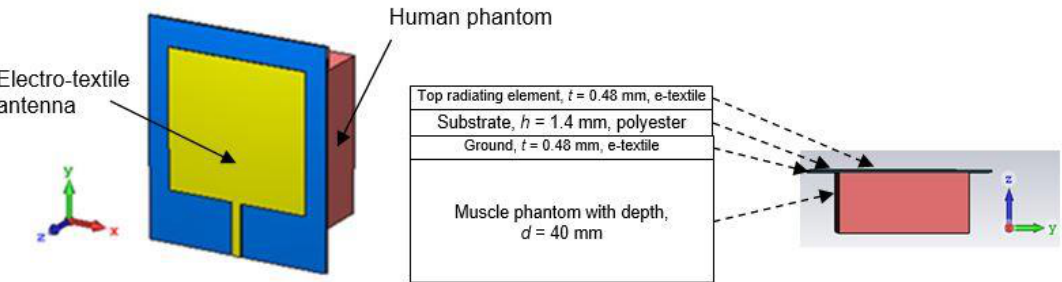
Figure 7. Configuration for on-body condition analysis (Case B). During simulation, the antenna is attached to the human phantom with various dielectric constant, ε r and conductivity, σ to represent the exact properties of human body fat, muscle and blood.